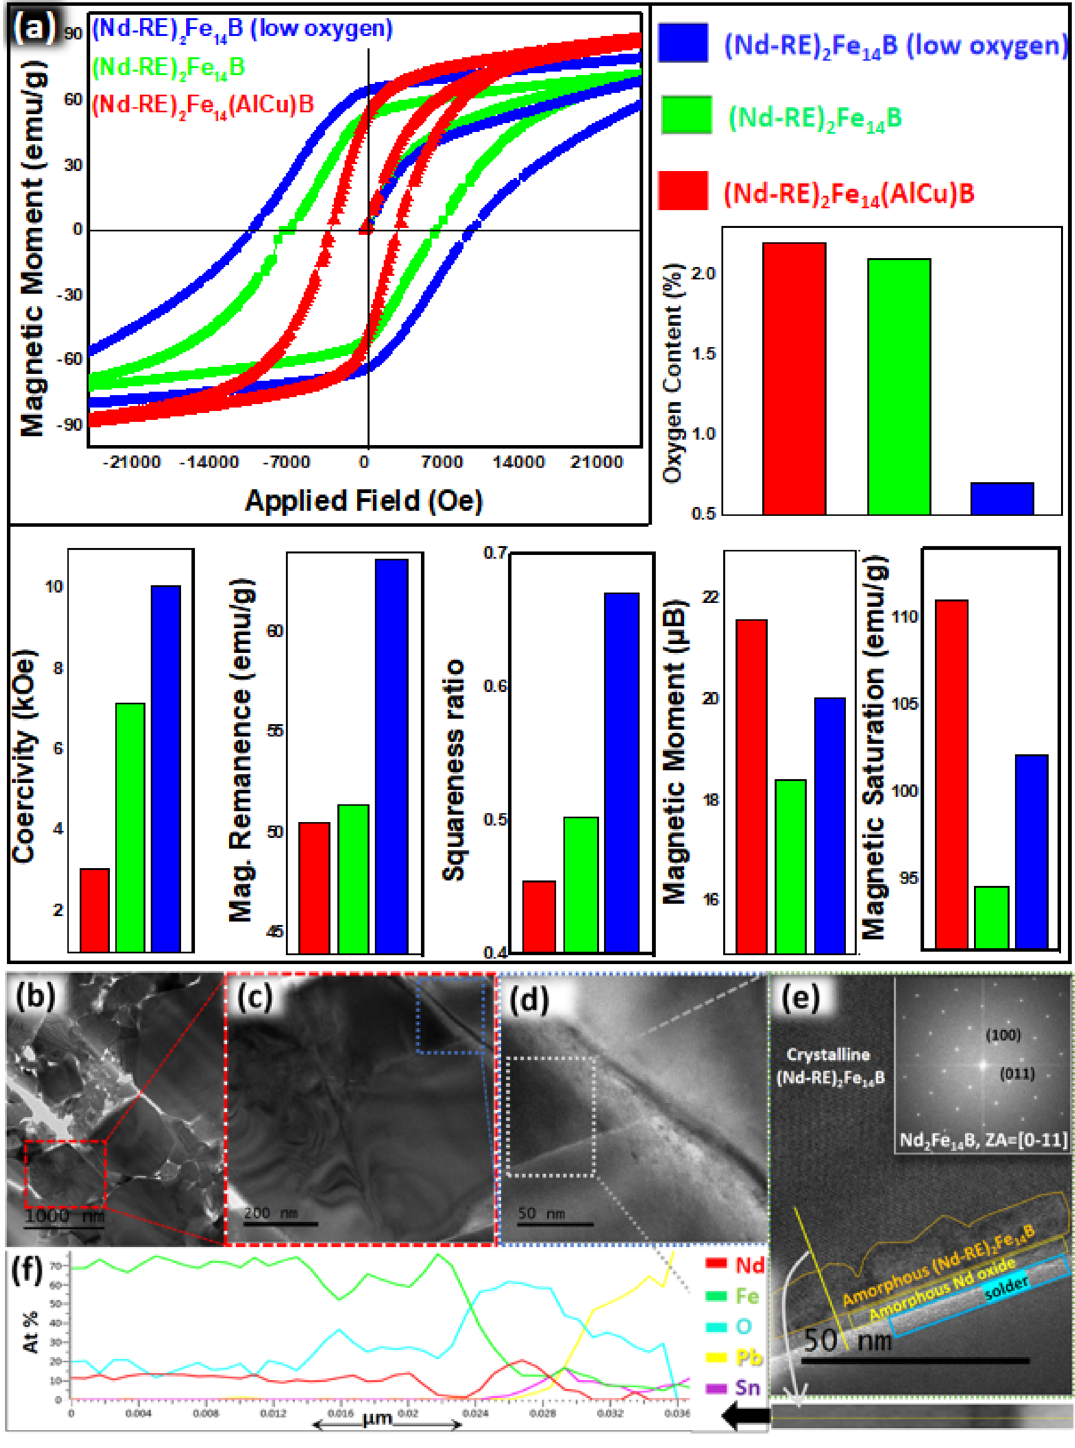
Figure 5. ( a ) Magnetic properties and oxygen content of all products ( b – d ) LAADF-STEM image of Nd 2 Fe 14 B ( e ) HAADF-STEM image from ( d ) ( f ) EDS line profile from ( e